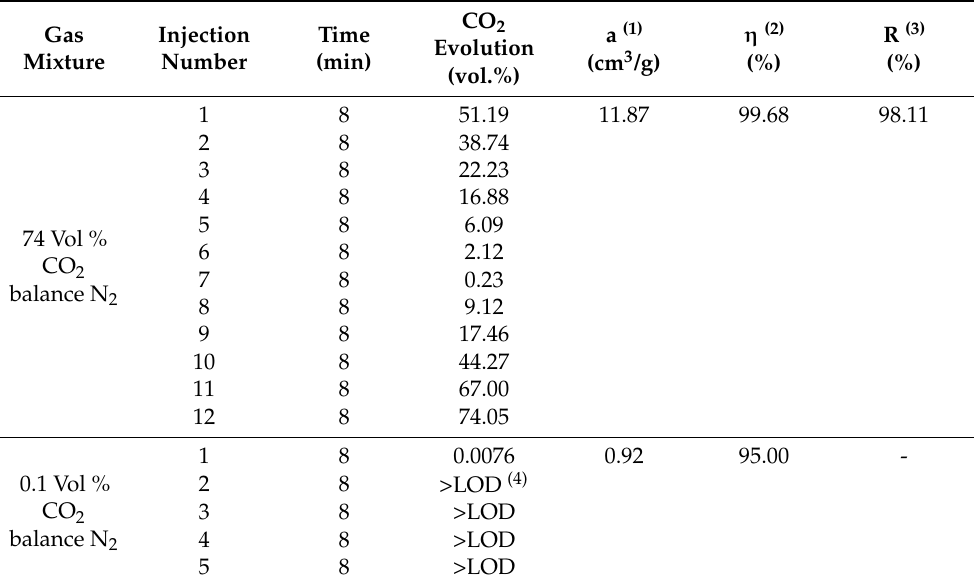
Table 5. CO 2 adsorption evolution and separation